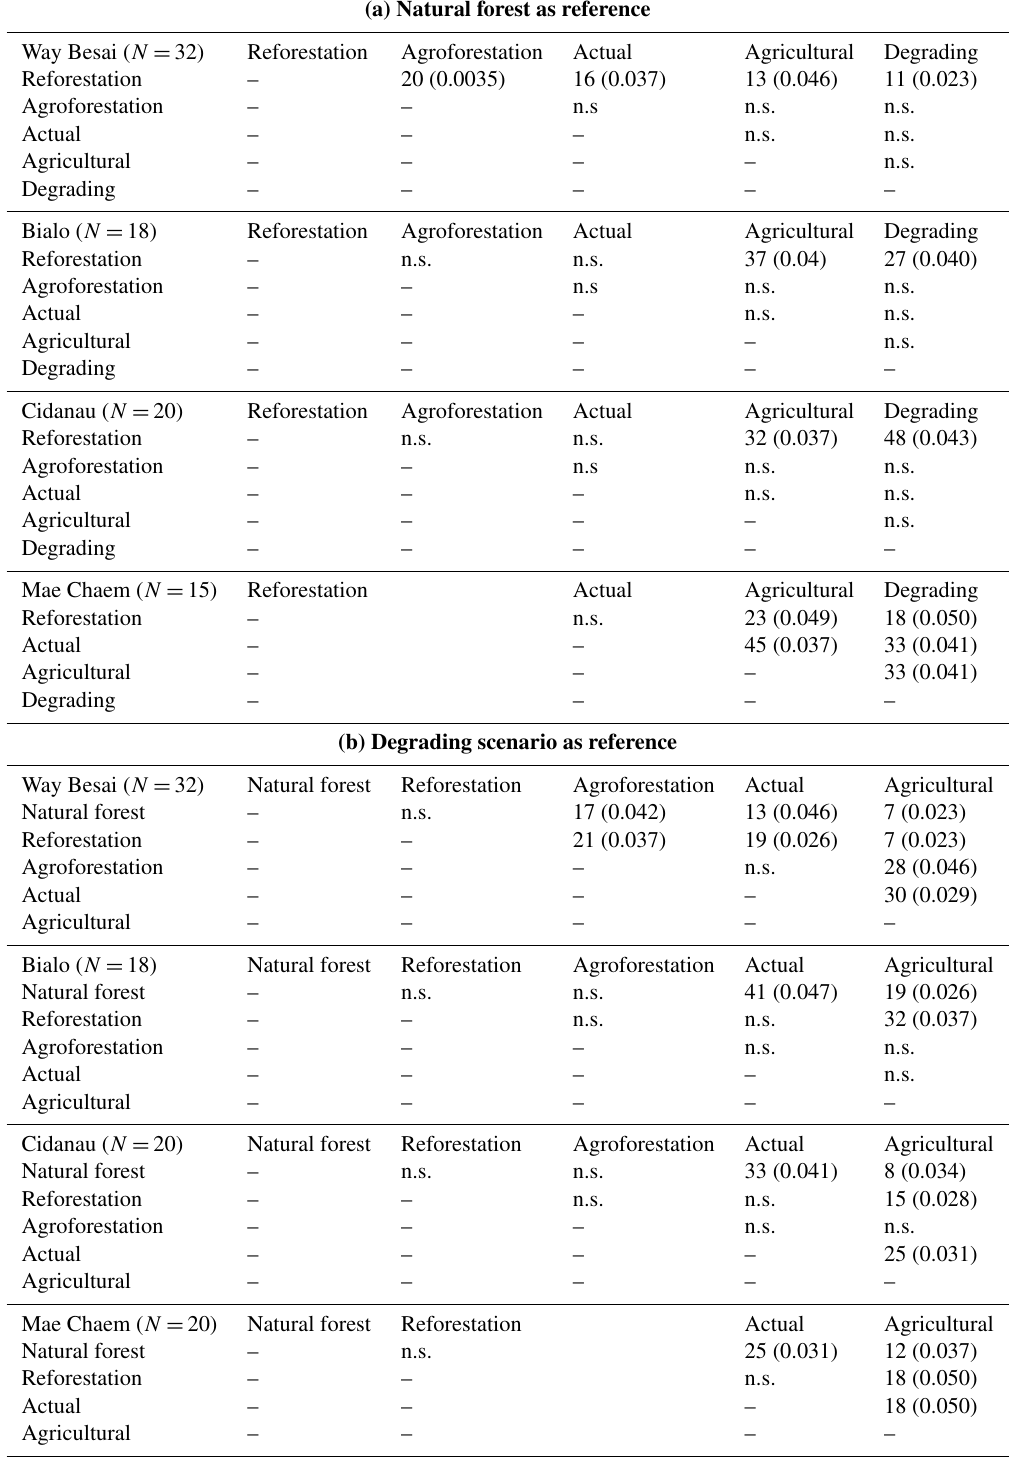
Table 5. Number of years of observations required to estimate flow persistence to reject the null hypothesis of “no land use effect”, at p value = 0.05 using Kolmogorov–Smirnov test. The probability of the test statistic in the first significant number is provided between brackets and where the number of observations exceeds the time series available, results are given in